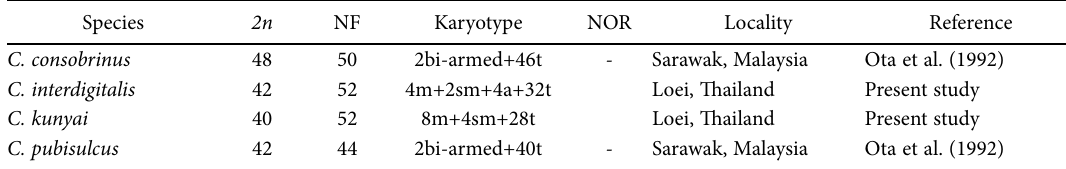
Table 3. Review of cytogenetic study of the genus Cyrtodactylus . Species 2n NF Karyotype NOR Locality Reference